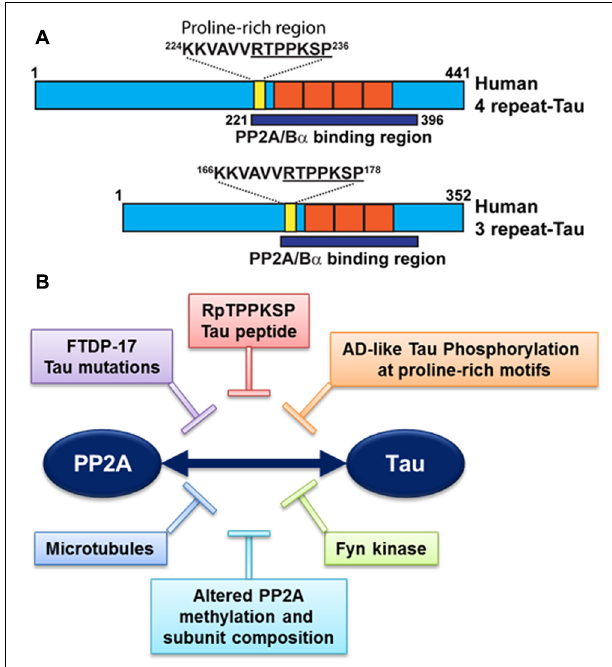
FIGURE 3 | Deregulation of PP2A-tau protein–protein interactions in AD. (A) The PP2A/B α holoenzyme can directly interact with three- or four-repeat human tau isoforms via a domain encompassing the microtubule-binding repeats (orange), resulting in tau dephosphorylation. A specific proline-rich motif (yellow) that contains theThr231 phosphorylation site plays a critical role in modulating PP2A-tau protein–protein interactions. (B) PP2A-tau protein–protein interaction can be inhibited in vitro by: (1) Alterations in tau, including AD-like phosphorylation and FTDP-17 missense mutations; (2) decreased expression levels of PP2A methylation and PP2A/B α in AD; (3) Fyn kinase and pseudophosphorylated RpTPPKSP peptides. Disruption of normal PP2A-tau interactions is predicted to affect tau phosphorylation state and